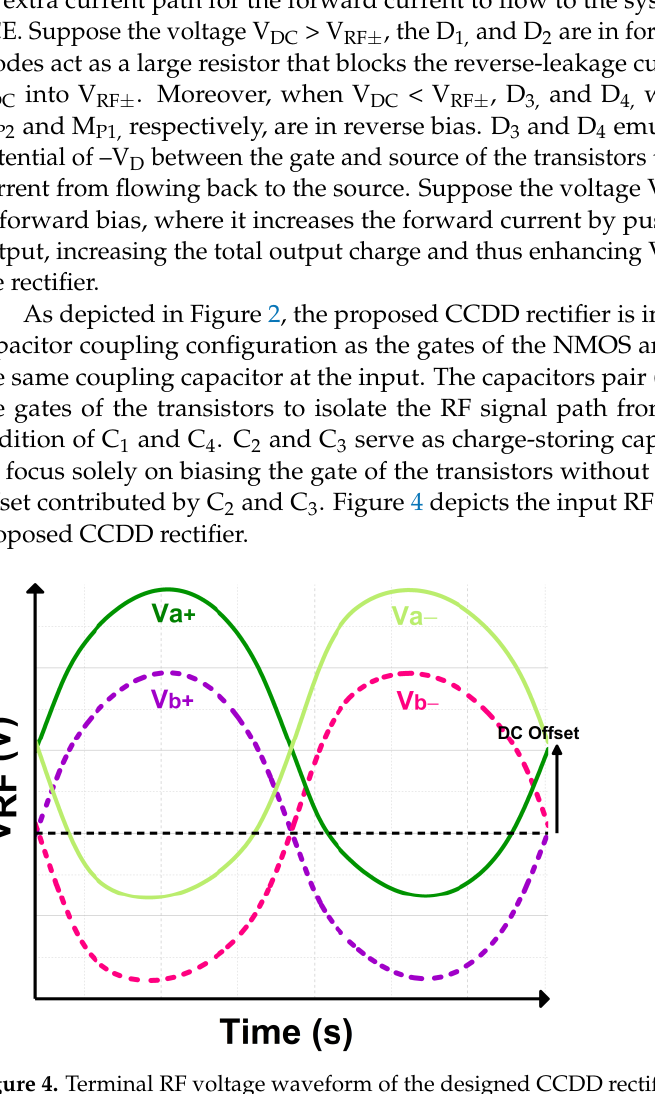
Figure 4. Terminal RF voltage waveform of the designed CCDD rectifier.